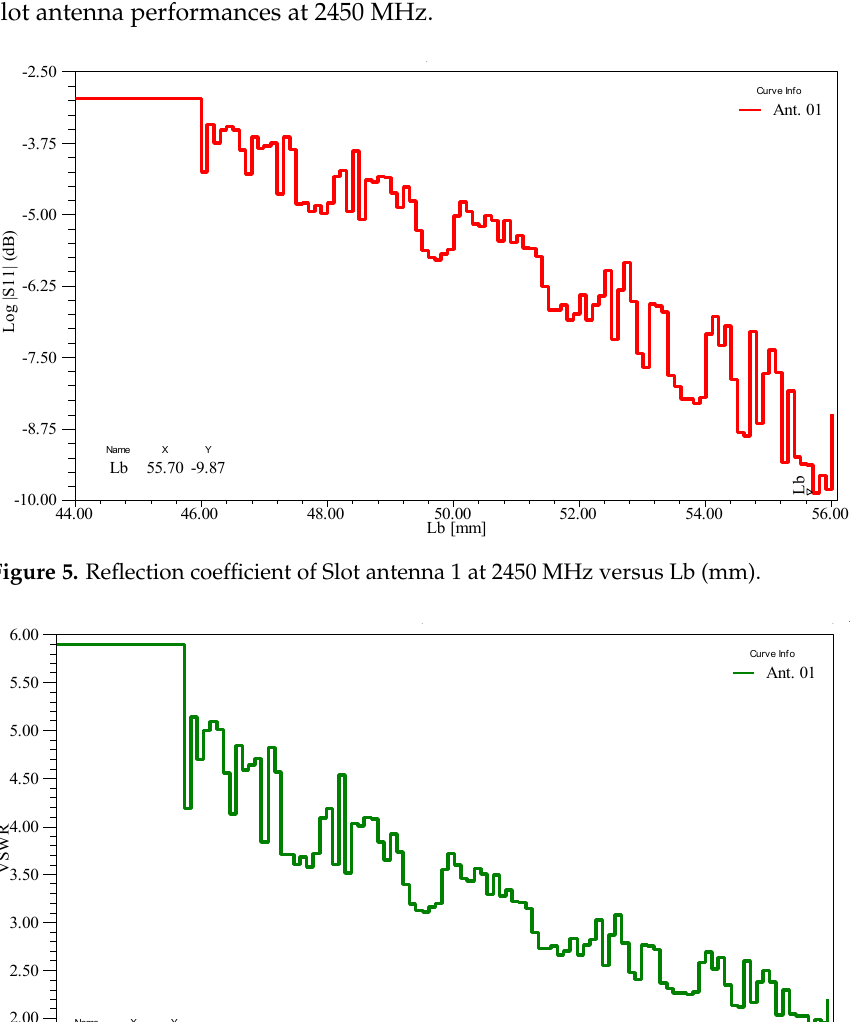
Figure 7. Real part of input impedance of Slot antenna 1 at 2450 MHz versus Lb (mm).